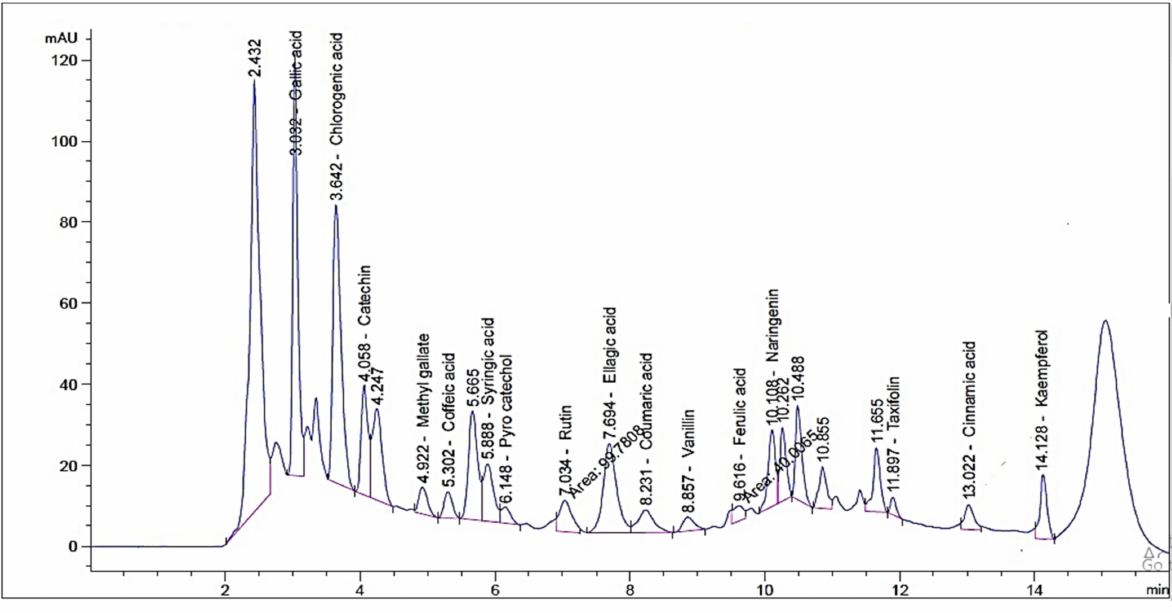
Figure 2. HPLC chromatogram of P. auriculata flowering aerial parts (ethanolic extract).